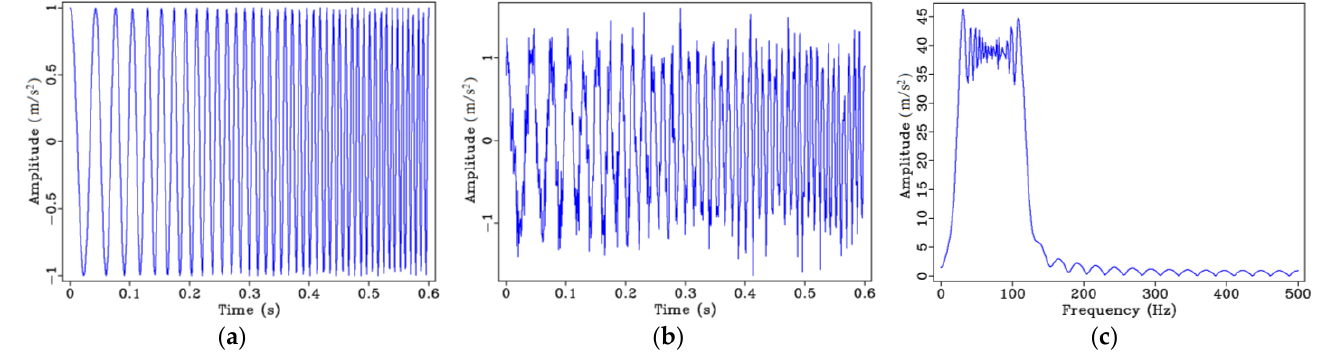
( c ) Figure 3. Nonlinear frequency-varying signal model: ( a ) Time domain signal; ( b ) time domain sig- nal with 10% random noise; ( c ) frequency spectrum of ( a ). 3.2. Time-Frequency Analysis of the Synthetic Signals 1. Parameter Selection Among the three time-frequency analysis methods selected in this paper, different parameters can be selected for calculating the STFT and LTFT. For example, for the STFT one can select a time window length depending on the signal analyzed. For the LTFT, a smoothing parameter can be set to control the time-frequency resolution. Taking the constant-frequency step signal as an example, Figure 4 shows the time-frequency spectra calculated by STFT with three different time window lengths. As can be seen, the longer the time window length, the higher the frequency resolution and the lower the time res- olution. Thus, when using the STFT, we need to evaluate the time window length ac- cording to the characteristics of the signal analyzed, instead of picking a predefined window length.